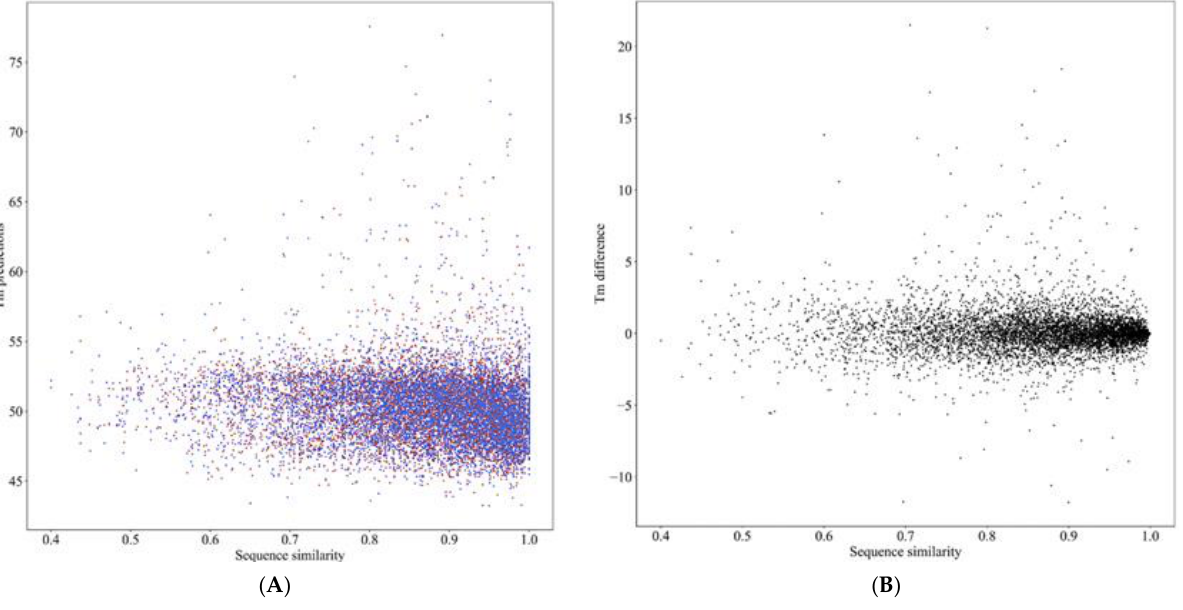
Figure 2. Comparison of predicted stabilities of human and mouse proteins. A total of 6492 orthologous pairs were compared. ( A ) Distribution of predicted T m values for human (red) and mouse (blue) proteins. ( B ) Difference of the predicted stabilities. Human proteins are on average slightly more stable than mouse proteins.